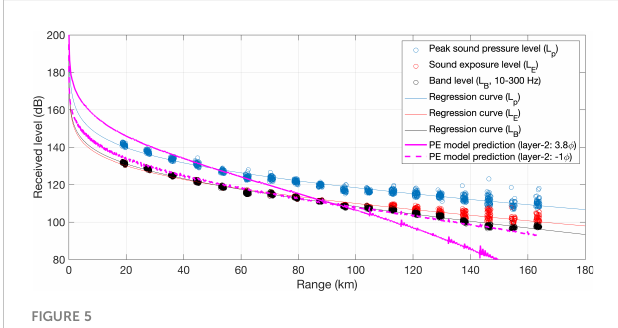
FIGURE 5 Received levels of airgun sound as a function of distance in L p , L E and L B , which are represented by cyan, red, and black circles, respectively. Thin lines with the same colors depict the linear regression fi tting curves using the least-squares method. Magenta solid and dashed lines show the PE model prediction curves when acoustic properties corresponding to 3.8 and -1 f were applied,